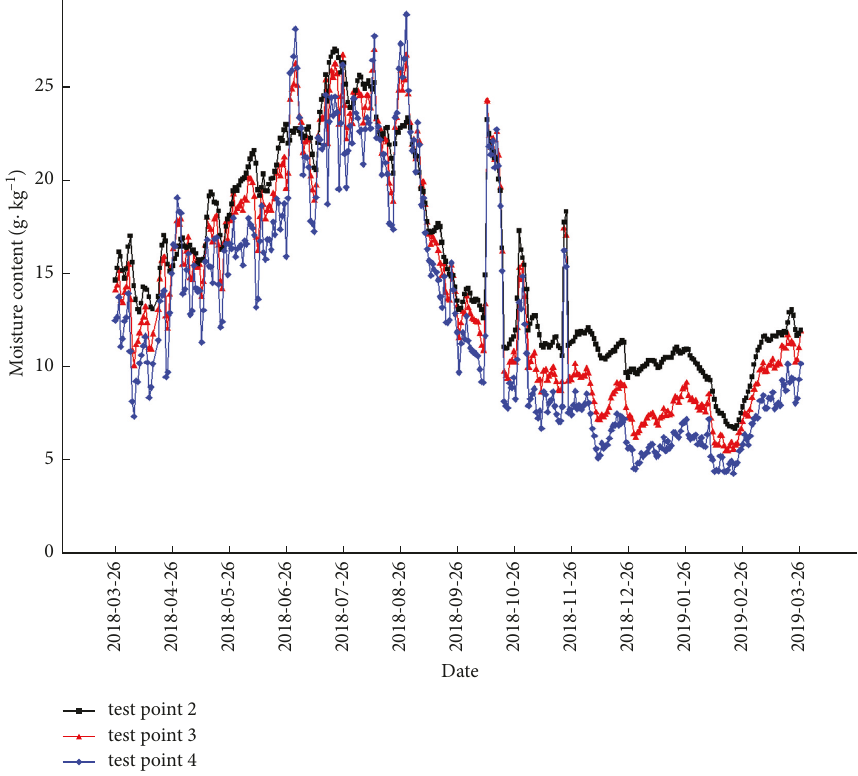
Figure 8: The curve of average daily moisture content inside the east wall.